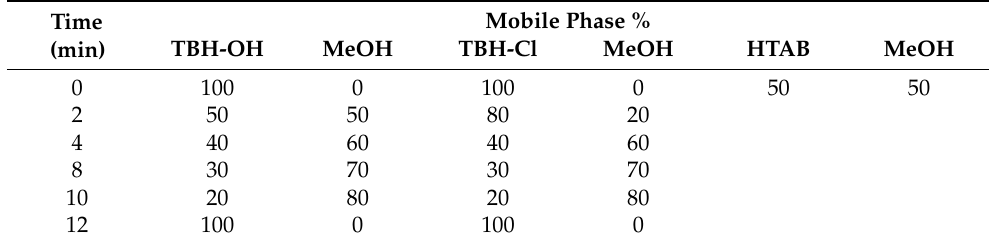
Table 1. Mobile phases for IP-CapLC method, flow rate 8 µ L/min. Ionic pairing agent solutions